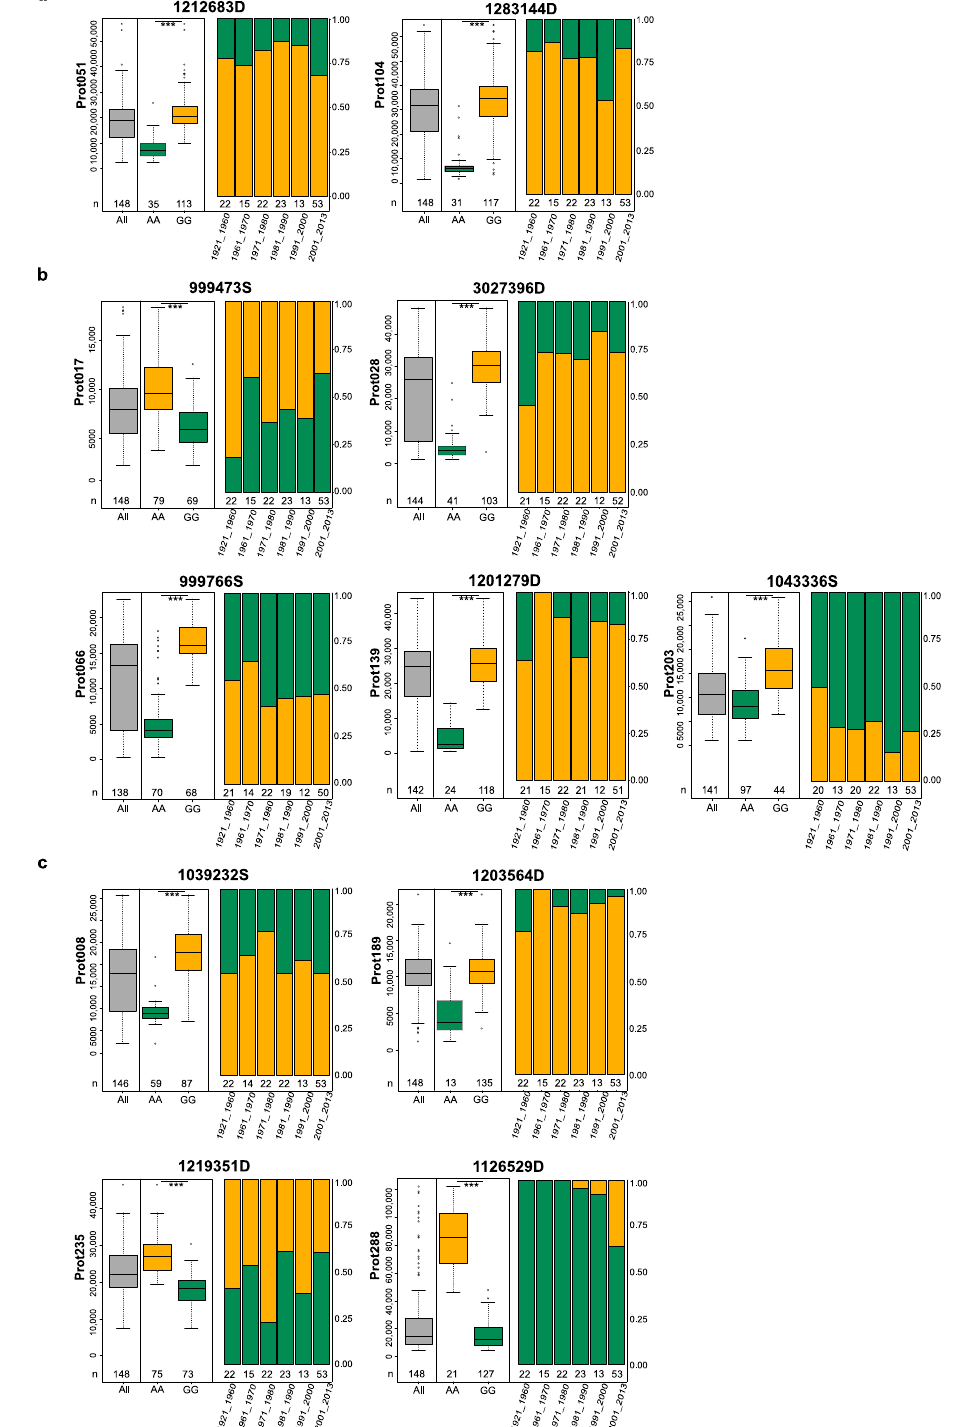
Figure 4. The effect of the major QTLs for gluten proteins prot051 and prot104 ( a ); gluten and allergenic proteins prot017, prot028, prot066, prot139, and prot203 ( b ); and non-gluten allergenic proteins prot008, prot189, prot235, and prot288 ( c ), and their allele frequencies according to the cultivar’s year of release (numbers below boxes represent the number of cultivars in the respective group). The leftmost boxplot in gray show the protein values for all cultivars. The protein-increasing allele is colored in orange; The protein-decreasing allele is colored in green. *** indicates significant difference at p < 0.001 between the two groups of cultivars containing contrasting alleles of a given